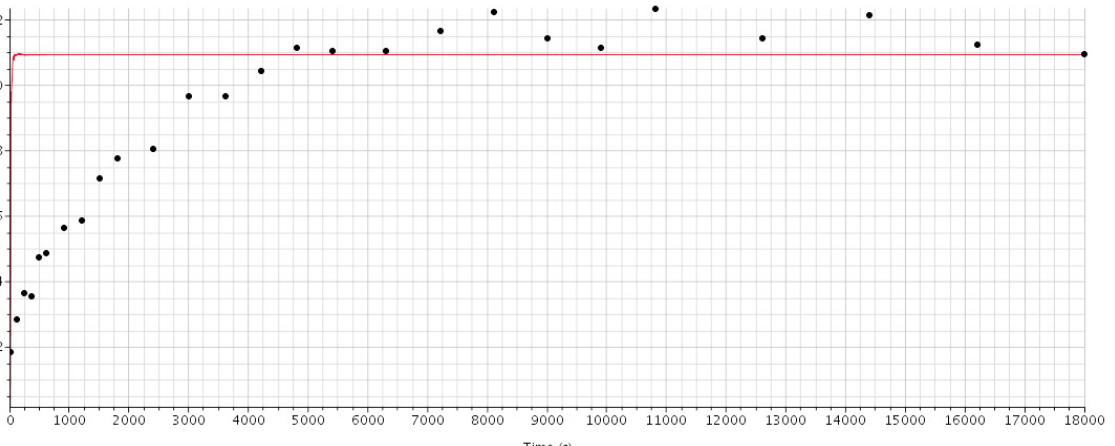
Figure 4. Comparison of the proposed meshes with a time of 45 s: ( a ) first mesh, ( b ) second mesh, and ( c ) third mesh.